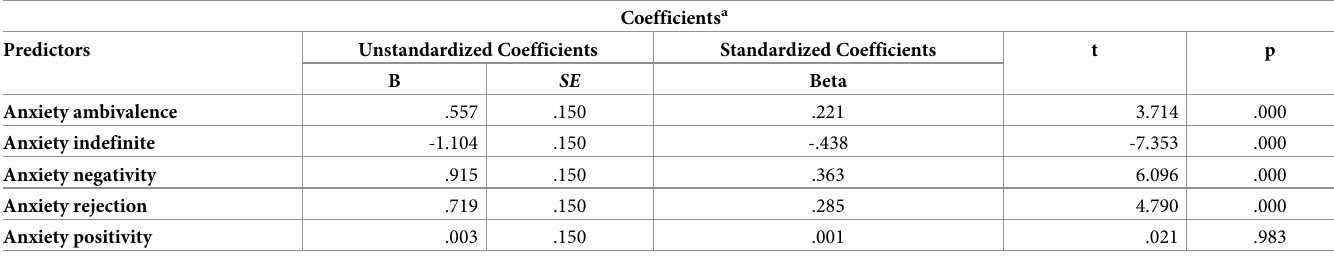
Table 10. Anxiety script: Multiple regression analysis; script’ factors predict